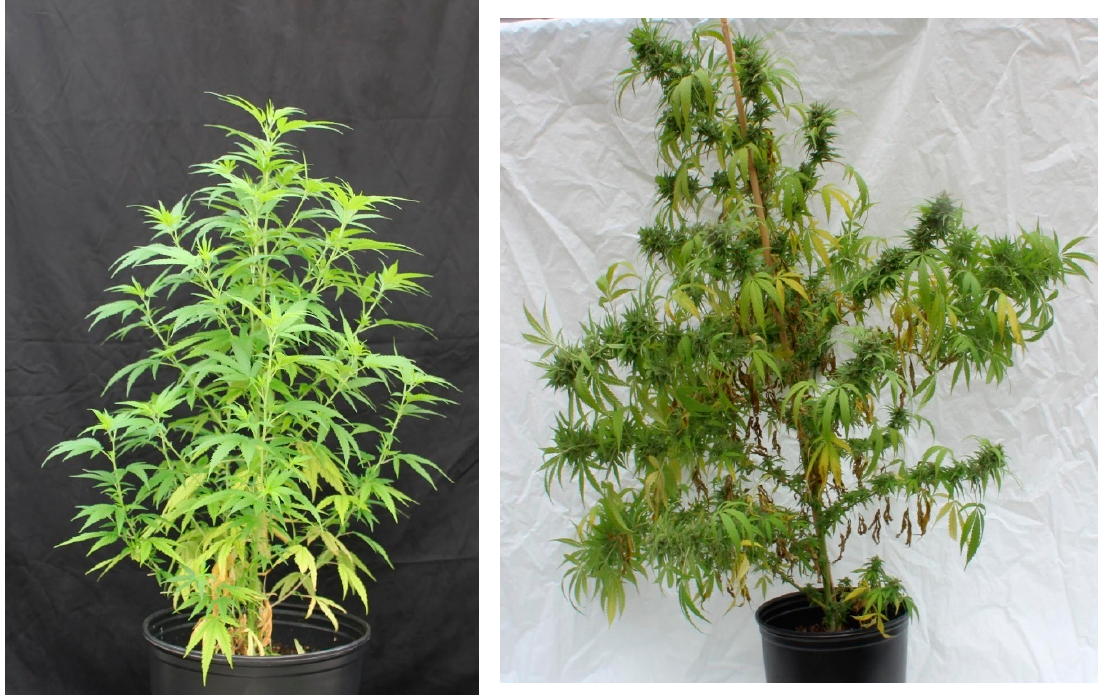
Figure 4. Comparison of a vegetative stage (left) vs. reproductive stage (right) C. sativa “BaOx” plant both grown at 30.0 mg·L − 1 P fertility. Notice specifically that the foliage leaves at the base of every node showing signs of olive green yellowing (right) which is indicative of P deficiency. These symptomologies were categorized in another work and thus are indicative of P deficiency (Cockson et al. [6]).